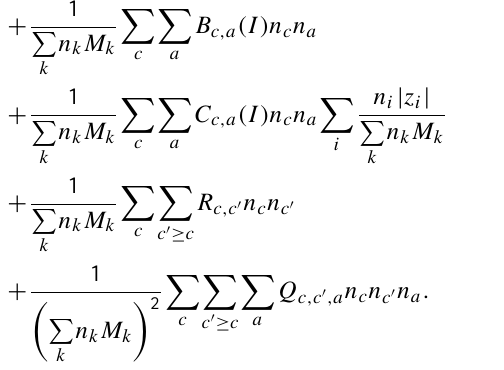
[ alc − tail ] n [in hydrophobic tails of